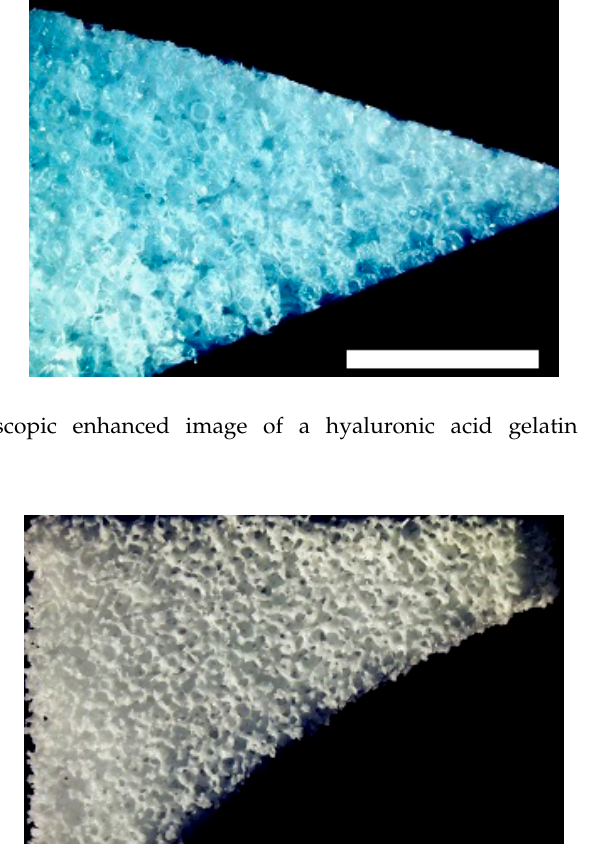
Figure 2. Macroscopic enhanced image of an Actifit ® scaffold. Scale bar = 1 mm.